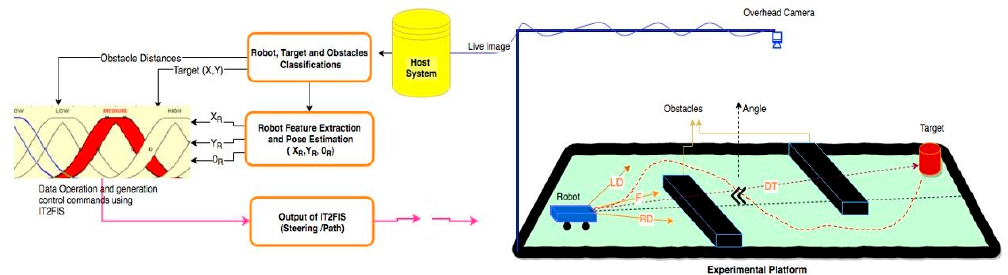
Figure 1. System architecture of vision-based path planning for mobile robot. Legend: IT2FIS, interval type-2 fuzzy logic; DT, distance from target; LD, left diagonal; F, front; RD, right diagonal (distance from obstacles and robot path).